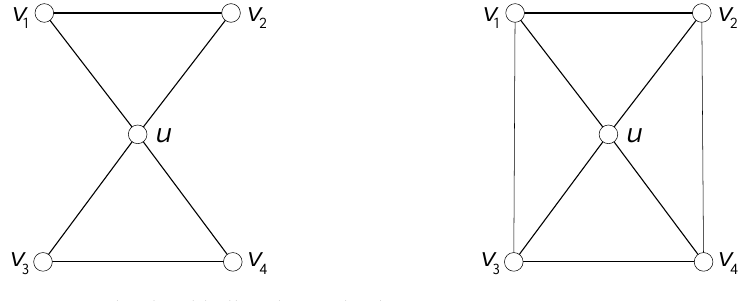
Figure 3. The dumbbell and a 4-wheel.